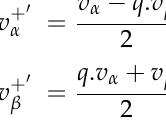
Figure 8. Bloc structure of proposed MSTOGI-MQT1-PLL.